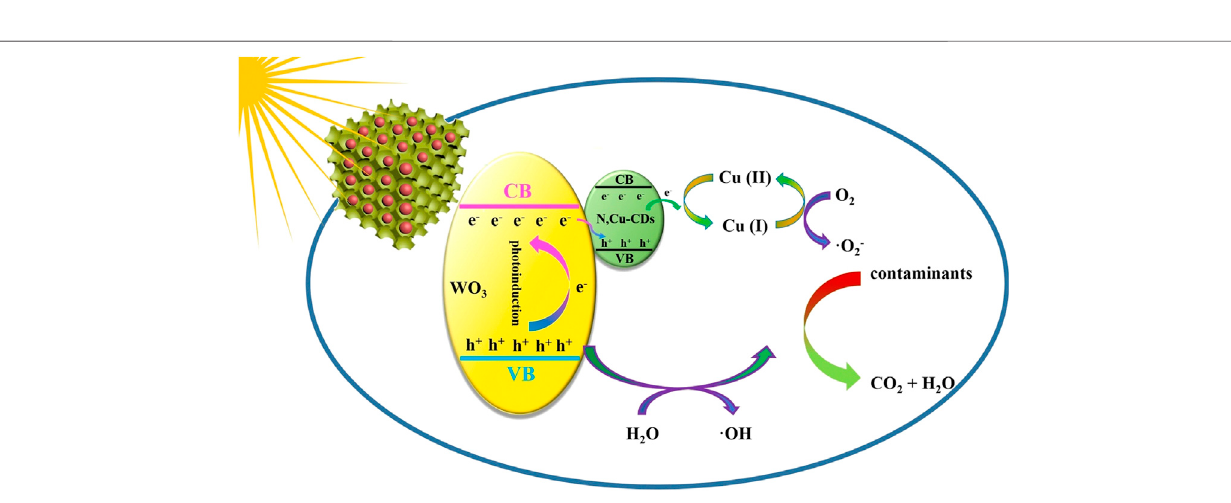
Frontiers in Materials |